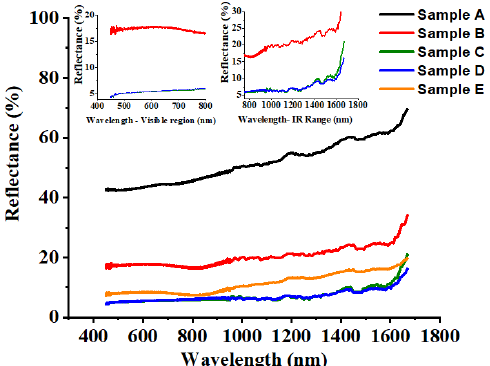
Figure 5. Spectral reflectance measurement results for samples A–E. In this work, the wavelength range for the reflectance measurement is from 450 to 1650 nm. According to the international standards, the wavelength ranging from 450 to 780 nm belongs to the visible spectrum and the wavelength ranging from 780 to 1650 nm belongs to the IR spectrum.